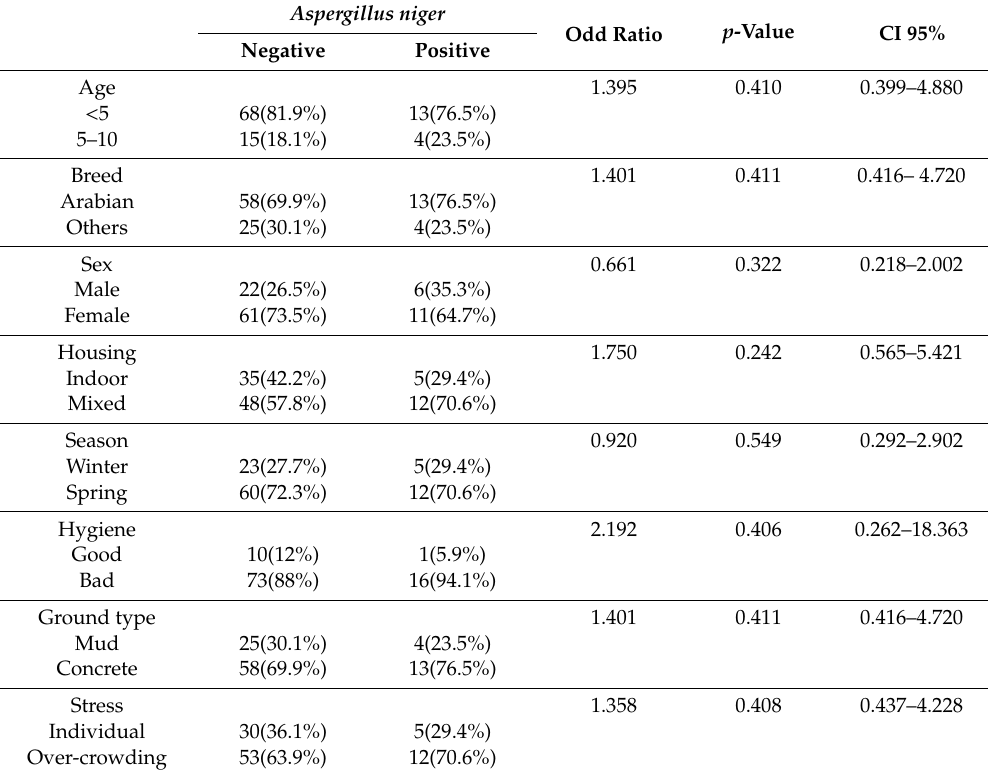
Table 5. Risk factors of Aspergillus